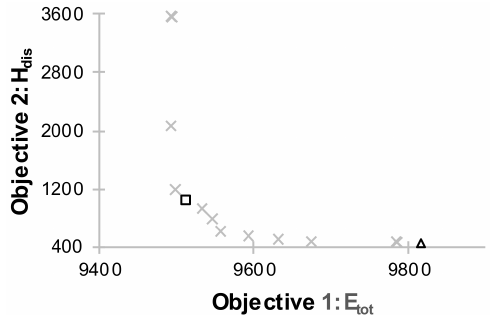
Figure 8. Pareto front for case